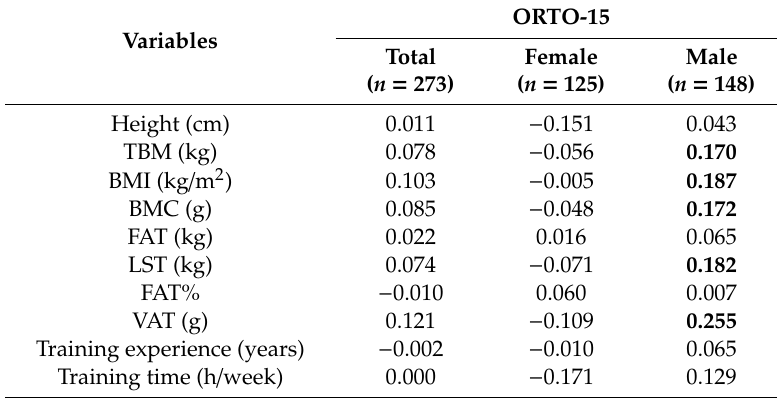
Table 4. Relationship between ORTO-15 score and anthropometric measurements, body composition, training experience and physical loads in athletes including